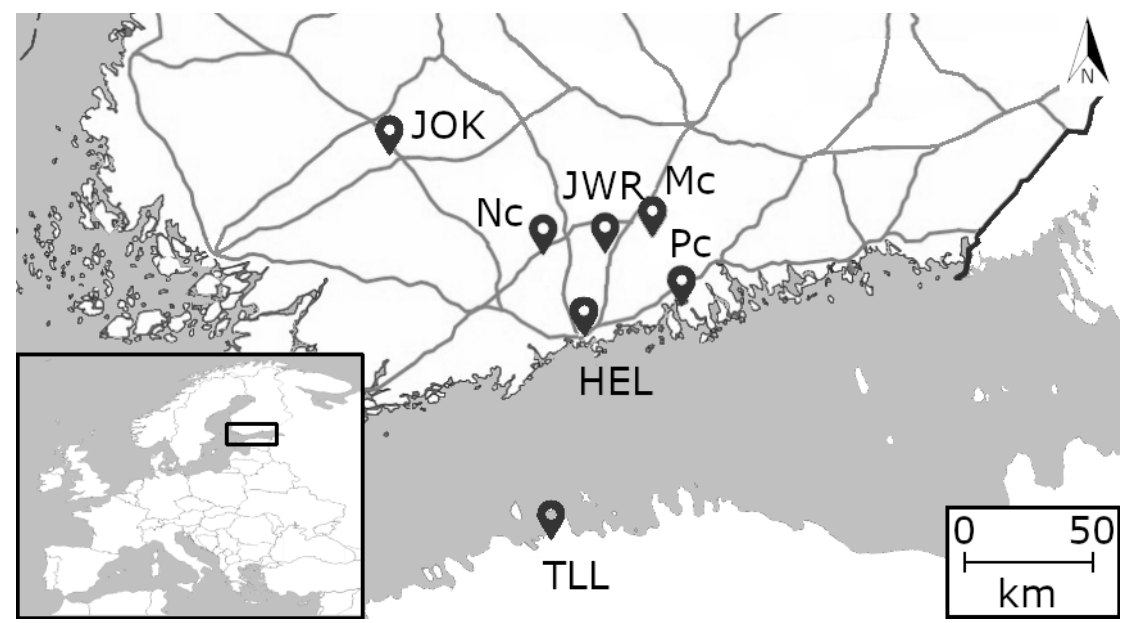
Figure 1. The map shows the main roads and observation systems used in the present study: Kumpula weather radar (HEL) in Helsinki; Järvenpää weather radar (JWR); ceilometers at Nurmijärvi (Nc), Porvoo (Pc), Mäntsälä (Mc), and Helsinki (HEL); and the atmospheric sounding stations at Jokioinen (JOK) and Tallinn, Estonia (TLL).